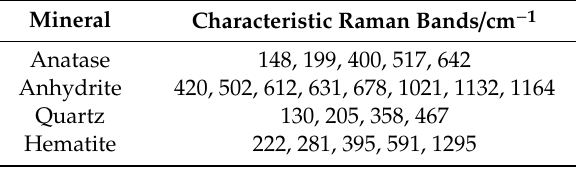
Table 5. Raman bands of minerals in coal